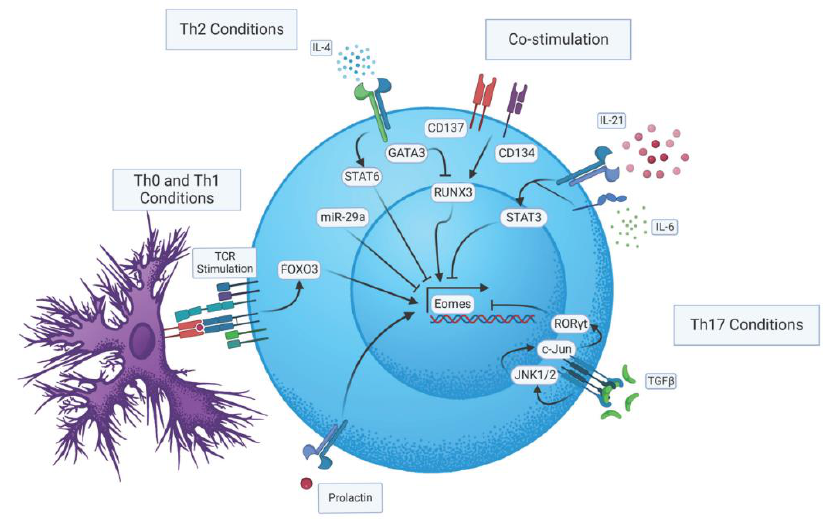
Figure 1. Regulatory pathways impacting Eomes expression in CD4 T cells.